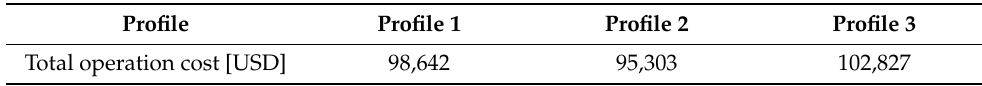
Table 3. Total operation cost for different